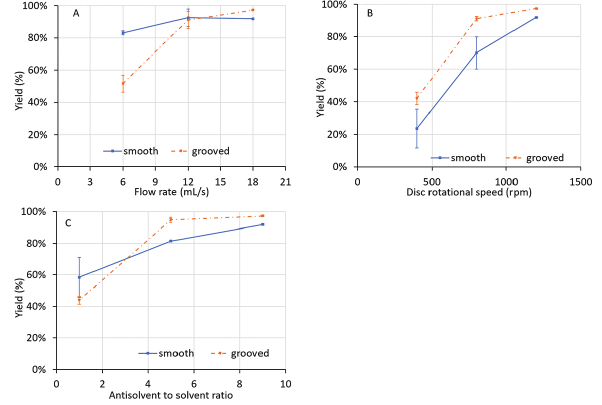
Figure 16: Yields for smooth and grooved discs for the effect of (a) flow rate (1200 rpm, 9:1 ratio), (b) disc rotational speed (18 mL/s, 9:1 ratio), (c) antisolvent to solvent ratio (1200 rpm, 18